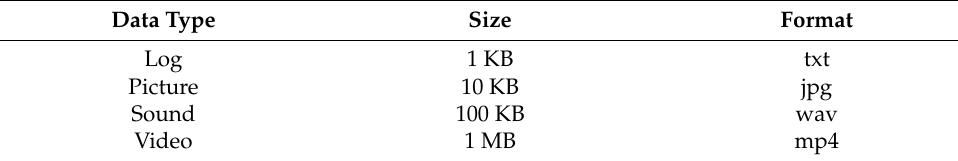
Table 5. Dataset for IoT